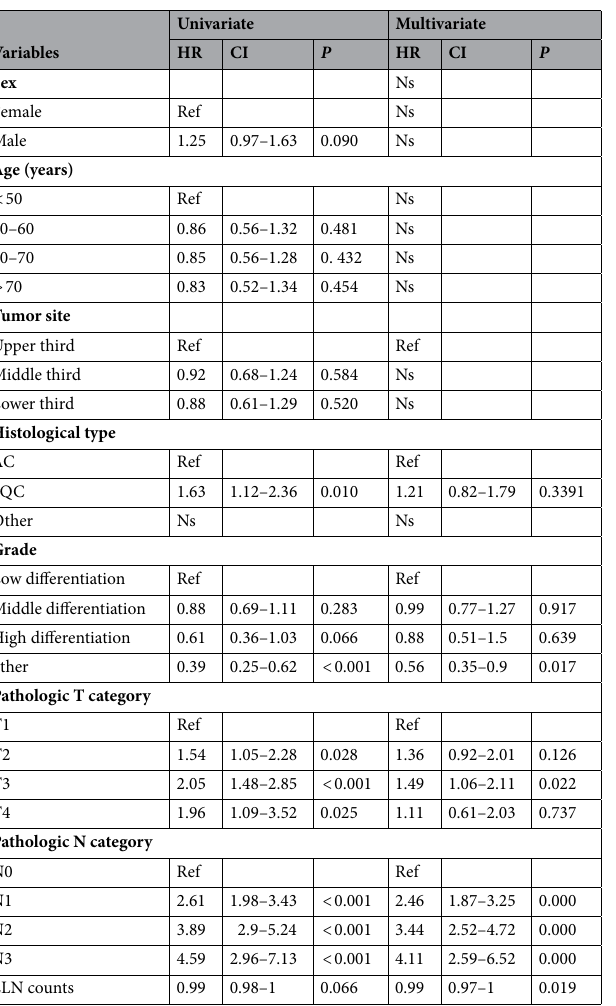
Table 3. Cox regression analysis of lymphadenectomy number on DFS in single database. SQC Squamous-cell carcinoma, AC Adenocarcinoma, AJCC American Joint Committee on Cancer, ELN counts Examined lymph node counts, PLN counts Positive lymph node counts.